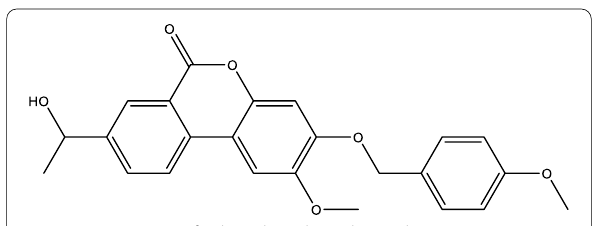
Fig. 6 2D structure of Palomid 529 ligand. 2D